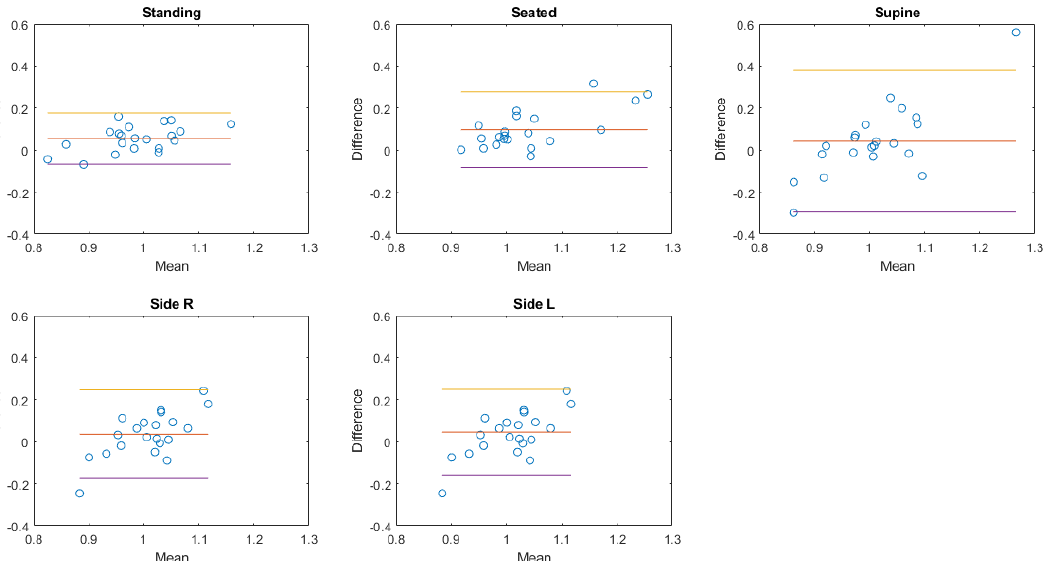
Figure 15. Bland–Altman plots of the aggregated results of normalized amplitude during exercise. Each dot represents the value obtained from a single subject. The yellow line represents the upper limit of agreement (mean error +1.96 × standard deviation); the red line represents the mean error; the purple line represents the lower limit of agreement (mean error −1.96 × standard deviation).